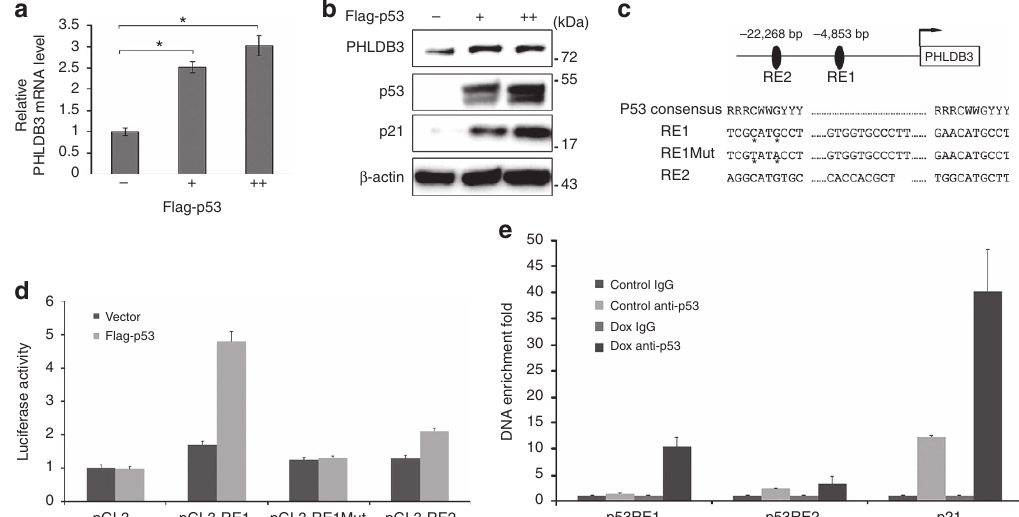
Figure 2 | PHLDB3 is a direct transcriptional target gene of p53. ( a , b ) The effect of p53 overexpression on PHLDB3 mRNA ( a ) and protein levels ( b ). H1299 cells were transfected with p53 and harvested 36h post-transfection. The relative PHLDB3 mRNA level was quantified by RT-qPCR. Data was corrected for GAPDH and represent mean ± s.e.m. of triplicate experiments. * P o 0.01 by two-tailed t -test ( a ). The PHLDB3, p53 and p21 levels were determined by immunoblotting with corresponding antibodies ( b ). ( c ) Two potential p53 responsive elements (RE1 and RE2) were identified in the human PHLDB3 promoter region using computer software (p53MH algorithm). The CATG to TATA mutation of RE1 was generated by site-directed mutagenesis. ( d ) p53 induces the activity of luciferase, whose expression was driven by the RE1, but not RE2 or mutated RE1, in the PHLDB3 promoter. Data represent mean ± s.e.m. of triplicate experiments.* P o 0.01 by two-tailed t -test. ( e ) p53 binds to the PHLDB3 promoter in cells. HCT116 p53 þ / þ cells were treated with 1 m M DOX for 16h, and ChIP assays were performed with the p53 antibody or control IgG. The promoter regions of indicated genes were analysed by RT-qPCR. * P o 0.01 by t